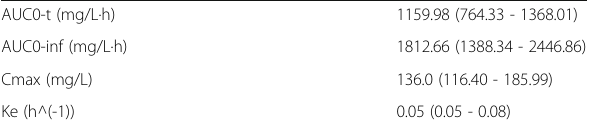
Table 1.2 (abstract 0398). Pharmacokinetic parameter estimates presented as median